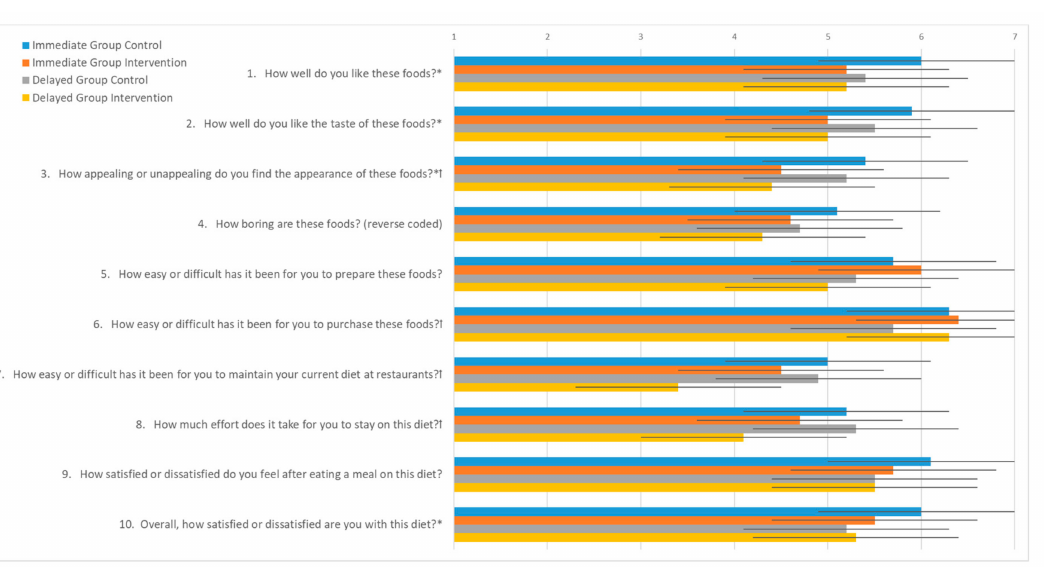
Figure 3. Food Acceptability Questionnaire with 7-point Likert scale responses from immediate and delayed intervention groups after control and intervention periods during a randomized controlled crossover high green leafy vegetable dietary intervention. Response options range from 1 (not at all/easy) to 7 (extremely (easy)). * indicates a significant difference ( p < 0.05) between control and intervention FAQ responses for Immediate Group. ꝉ indicates a significant difference ( p < 0.05) between control and intervention FAQ responses for Delayed